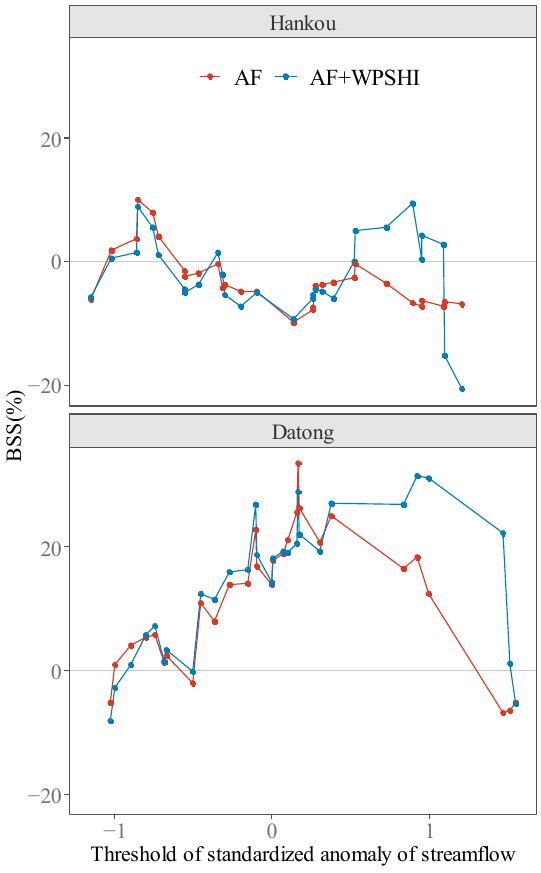
Figure 8. Brier skill score (BSS) of the forecast for summer streamflow of Hankou and Datong based on WPSHI(R). Two types of models are shown in the graph, i.e., the model only using antecedent streamflow (AF) and the model using both antecedent streamflow and WPSHI(R) as predictors (AF + WPSHI).